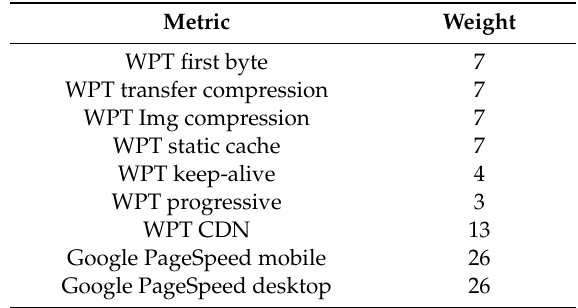
Table 4. Weights for the calculation of the website performance evaluation